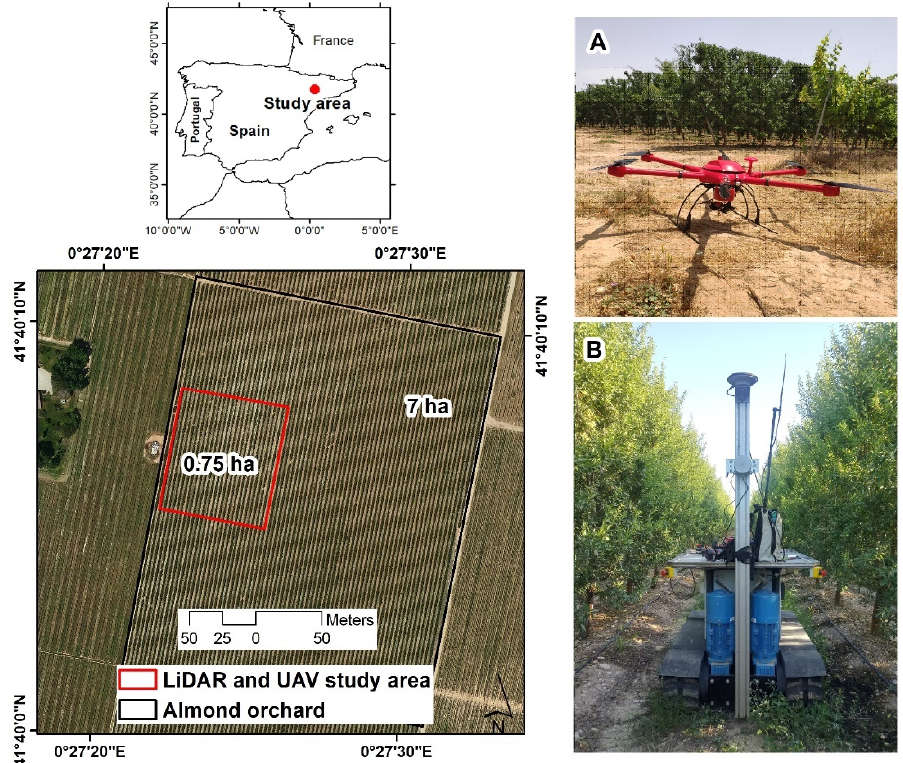
Figure 1. Left: Location of the study area. Coordinate system GCS WGS 1984. Right: Devices used for data acquisition. ( A ) DroneHexa (DroneTools, Sevilla, Spain) with a RedEdge-MTM camera (Micasense, Seattle, WA, USA); ( B ) mobile terrestrial laser scanner system for data acquisition.